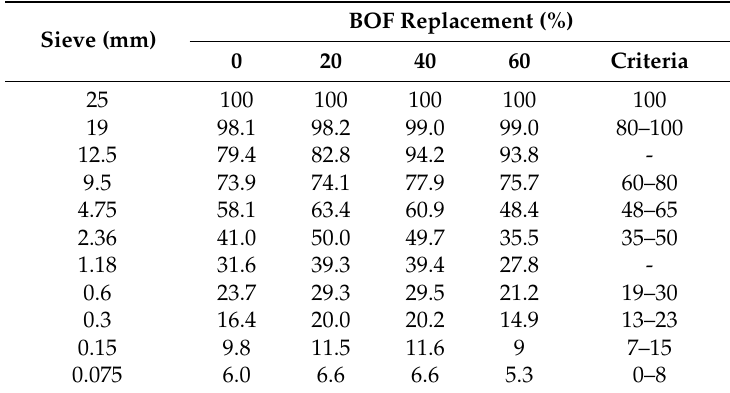
Table 3. Sieve distribution (dense-graded mixture).